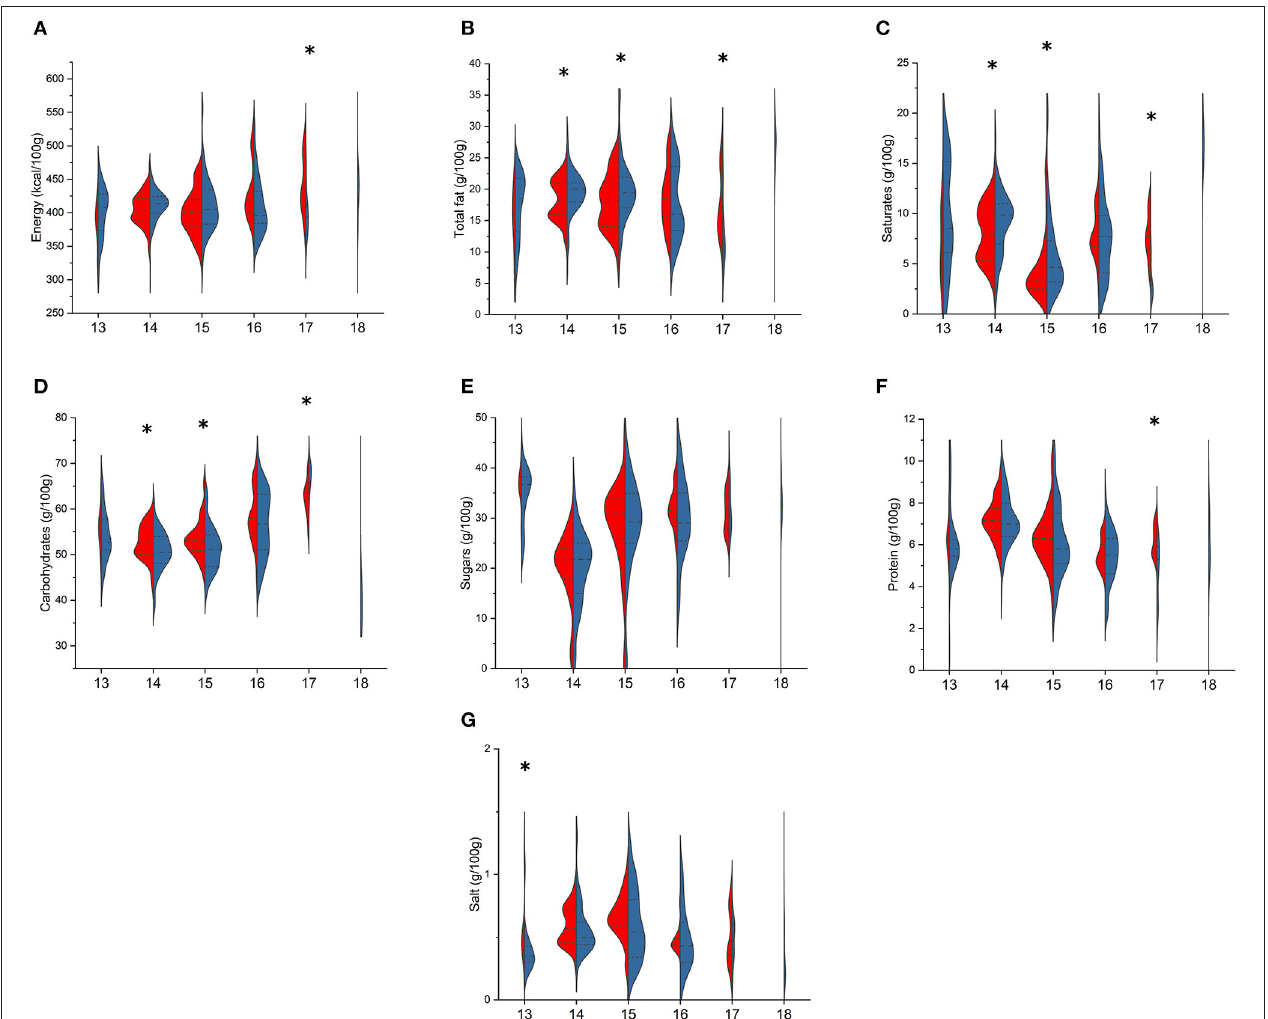
FIGURE 3 | Comparison of energy (A) , total fat (B) , saturates (C) , total carbohydrates (D) , sugars (E) , protein (F) , and salt (G) content in branded (BR, in blue) and private-label (PL, in red) types of sweet snacks and cakes. 13: cream-filled sponge cake; 14: plain or cream/jam-filled croissant or “pain au chocolat”; 15: yogurt plumcake and muffin; 16: sponge cake; 17: cream/jam-filled shortbread cake; 18: cream-filled and/or covered chilled snack. For each type, asterisk indicates significant difference between BR and PL items (Mann–Whitney non-parametric test for two independent samples), p < 0.05.